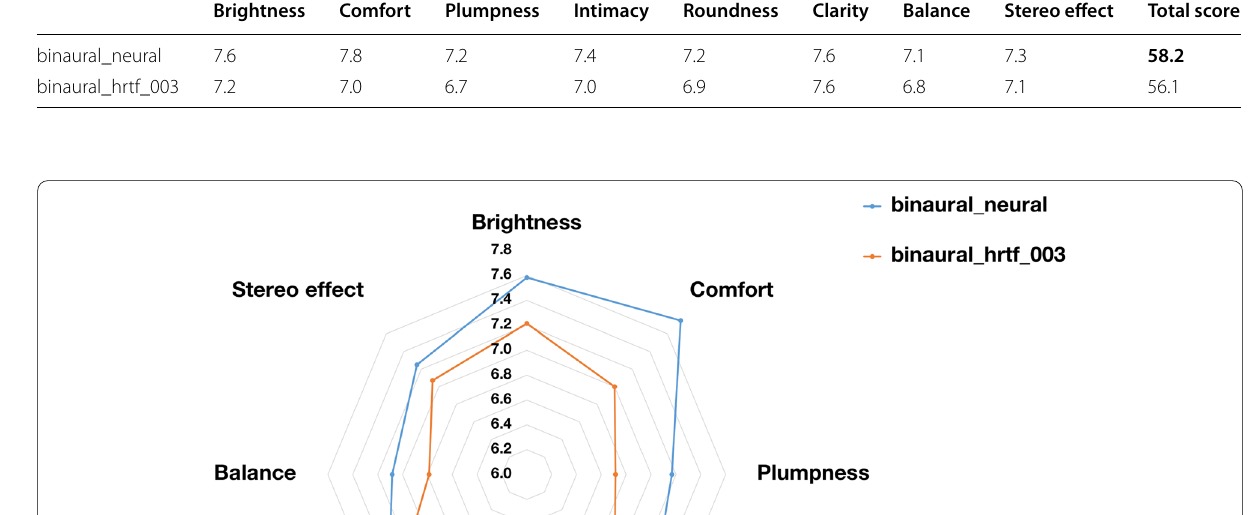
Table 5 Subjective evaluation score Brightness Comfort Plumpness Intimacy Roundness Clarity Balance Stereo effect Total score binaural_neural